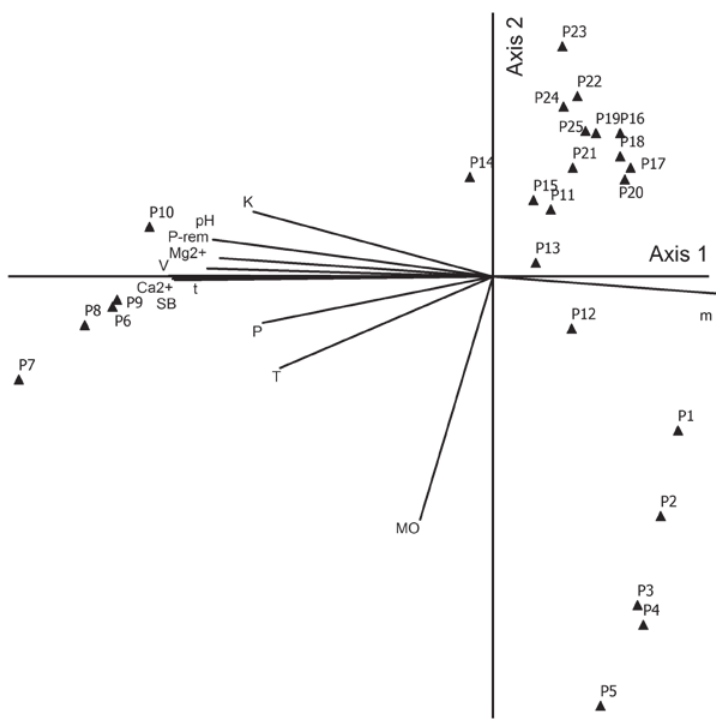
Figure 4 - Ordination of variables of soil in Paraopeba Forest Reserve, state of Minas Gerais, Brazil. P1 – P5